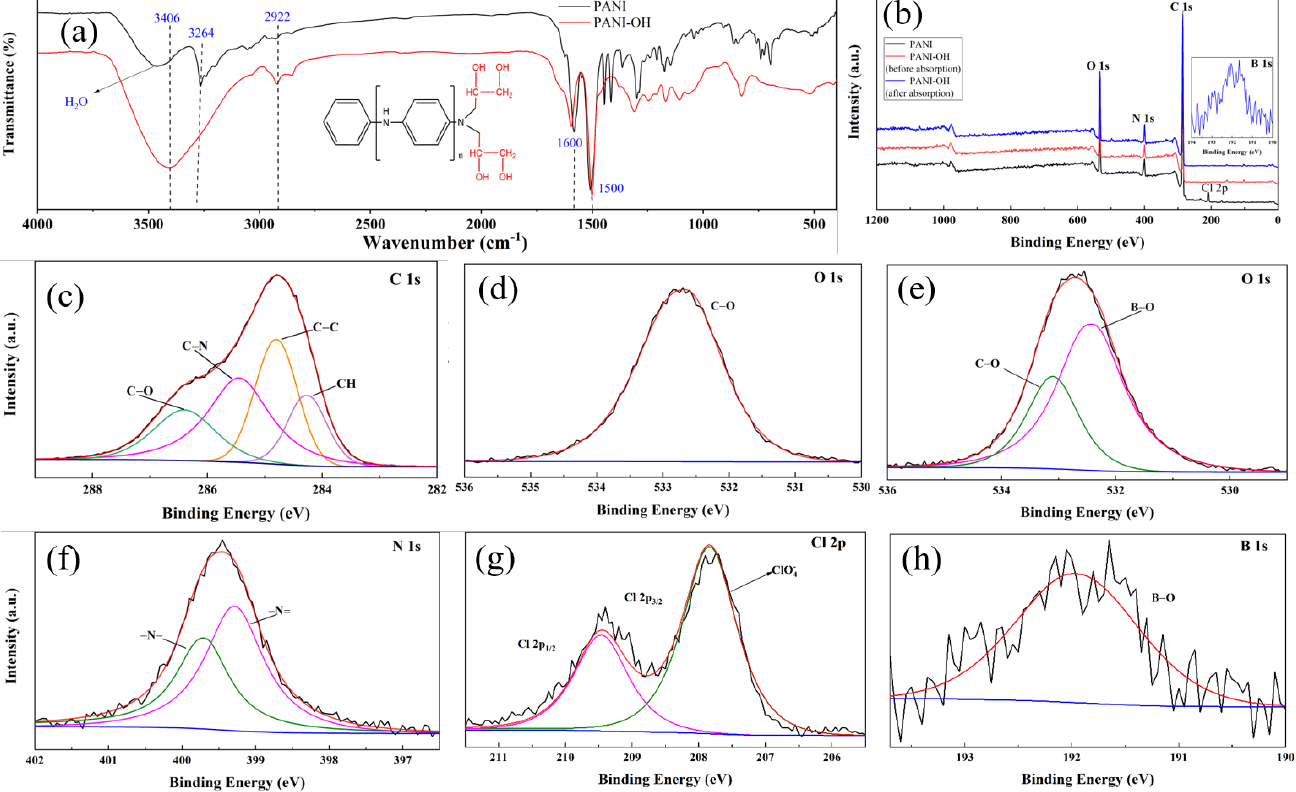
Figure 2. FTIR patterns of the as-prepared PANI and PANI-OH-3 composites ( a ) and the XPS spectra of the PANI and PANI-OH-3 as well as PANI-OH-3-B composite: experimental and fitted curves, ( b ) Full-scan XPS spectra of PANI, PANI-OH-3 and PANI-OH-3 after adsorption, ( c ) C 1s of PANI-OH-3, ( d ) O 1s of PANI-OH-3, ( e ) O 1s of PANI-OH-3-B, ( f ) N 1s of PANI-OH-3, ( g ) Cl 2p of PANI, and ( h ) Fe 2p of PANI-OH-3-B regions.